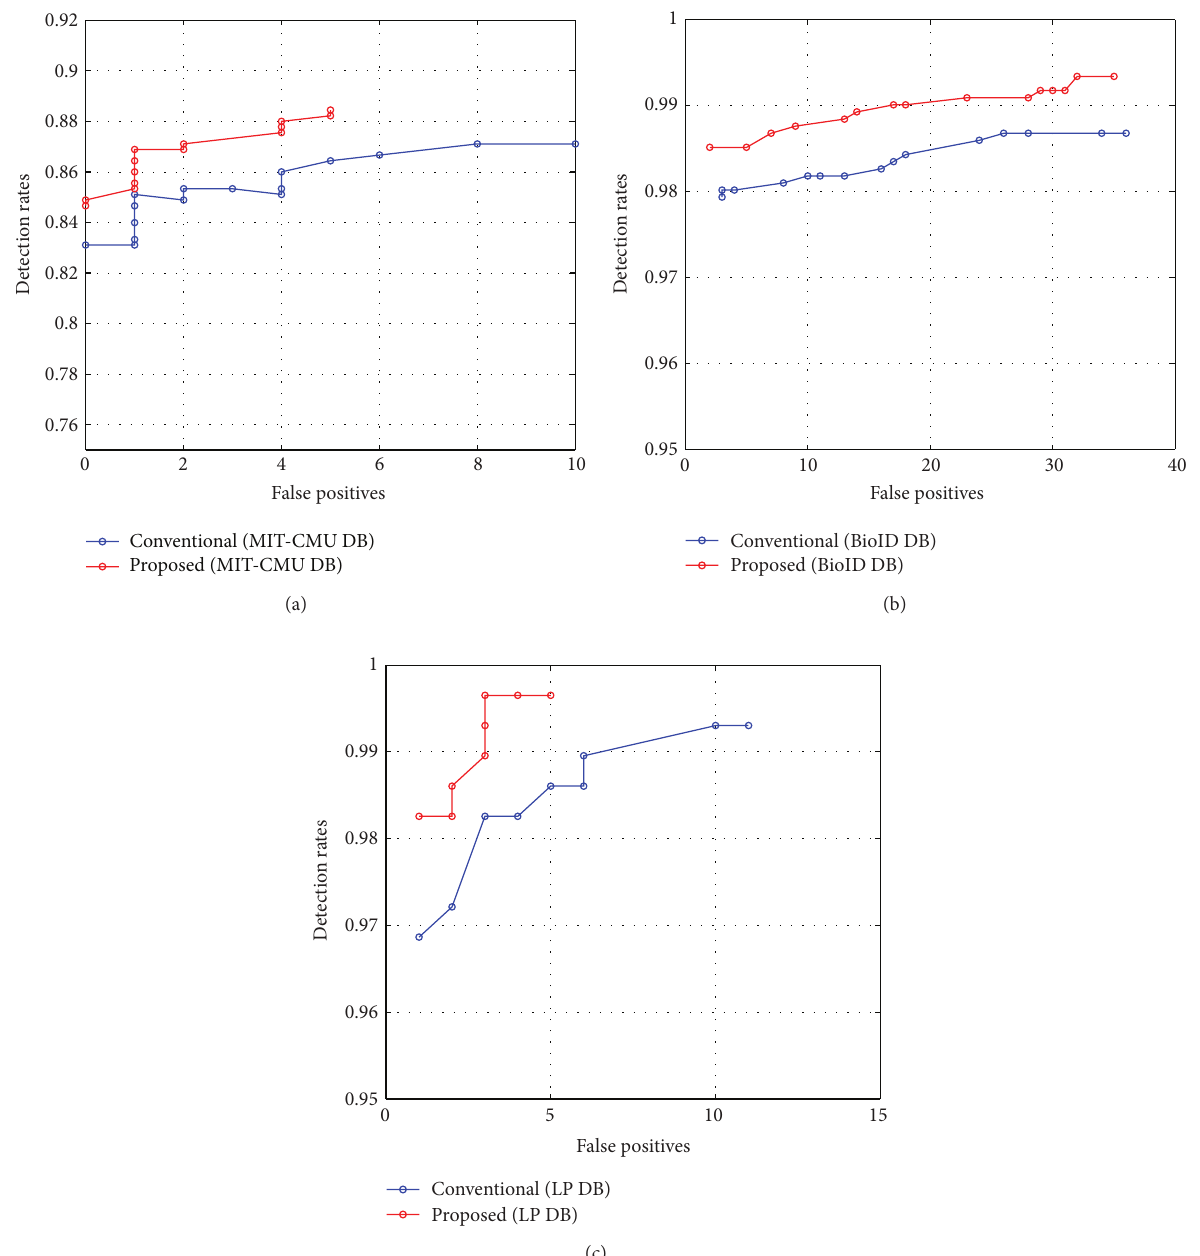
Figure 11: (a) Performance of face detector on MIT-CMU DB. (b) Performance of face detector on BioID DB. (c) Performance of license plate